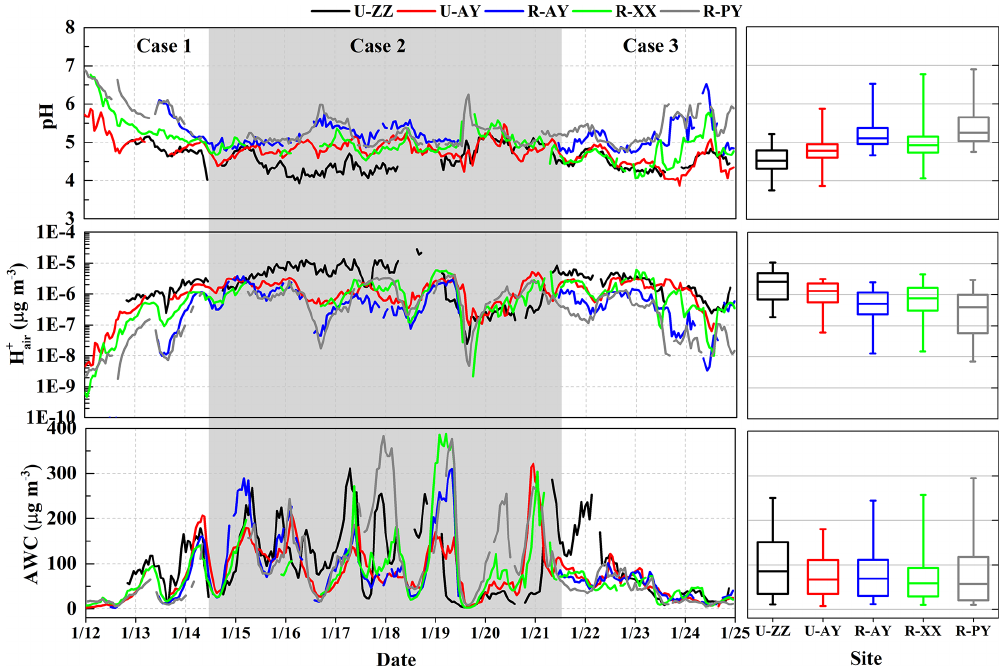
Figure 3. Time series and box plot of predicted PM 2 . 5 pH, H + air , and aerosol water content (AWC) at the five sites. In each box, the top, middle, and bottom lines represent the 75, 50, and 25 percentile of statistical data, respectively; the upper and lower whiskers represent the maximum and minimum values, respectively.